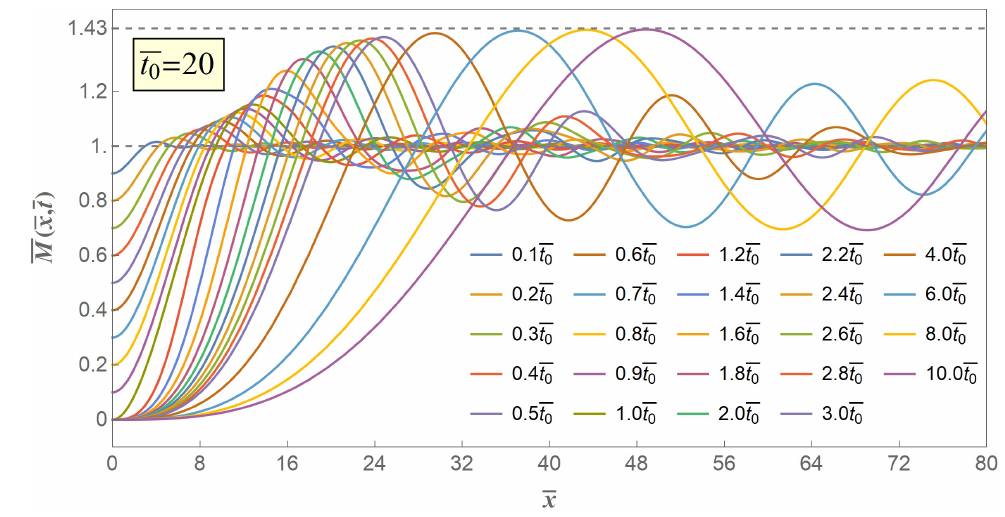
Figure 6. Schematic of excited bending moment versus distance when t 0 =